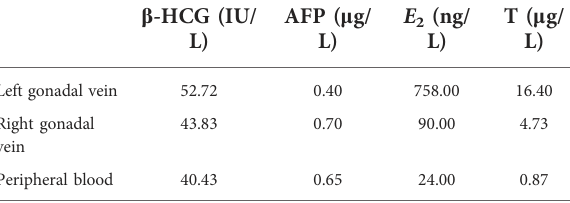
TABLE 1 The hormone level from bilateral gonadal veins and peripheral vein.